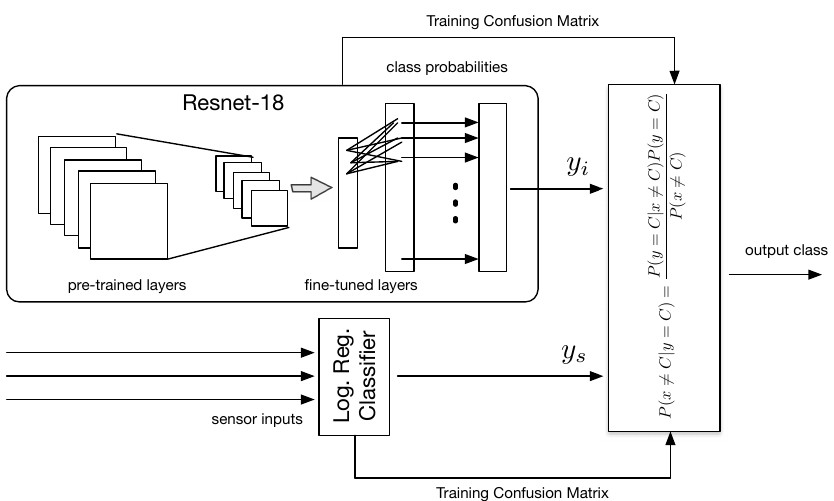
Figure 10. Integration at prediction